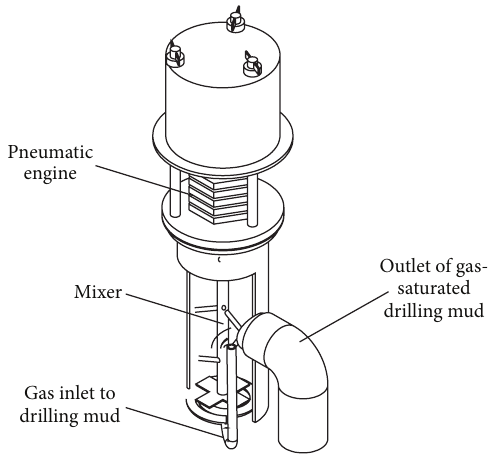
Figure 4: The scheme showing the gas saturation